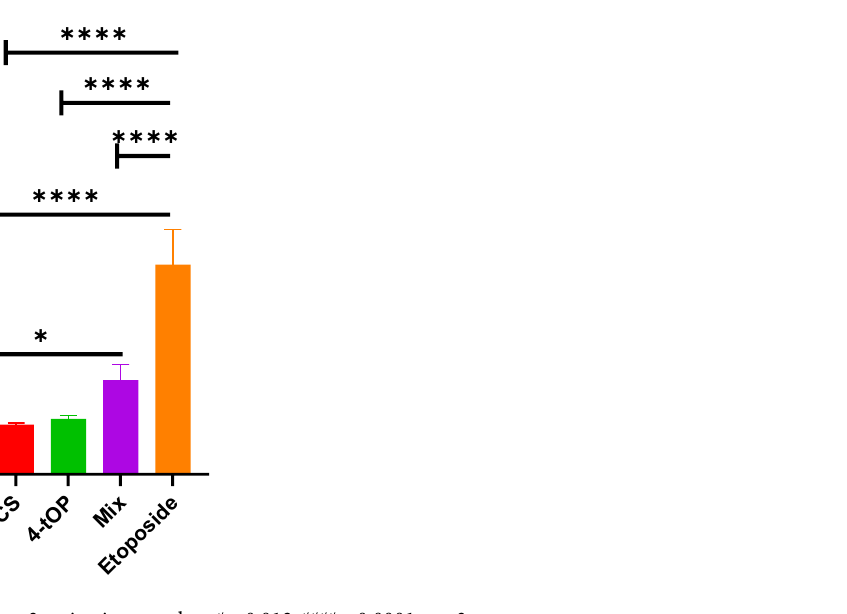
Figure 9. Caspase 3 activation. p values * = 0.012, **** = 0.0001, n =